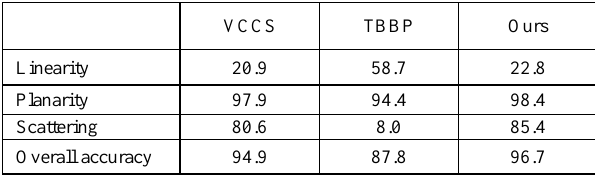
Table 1. Labelling accuracy (%) of the TLS test data based on supervoxels generated by different